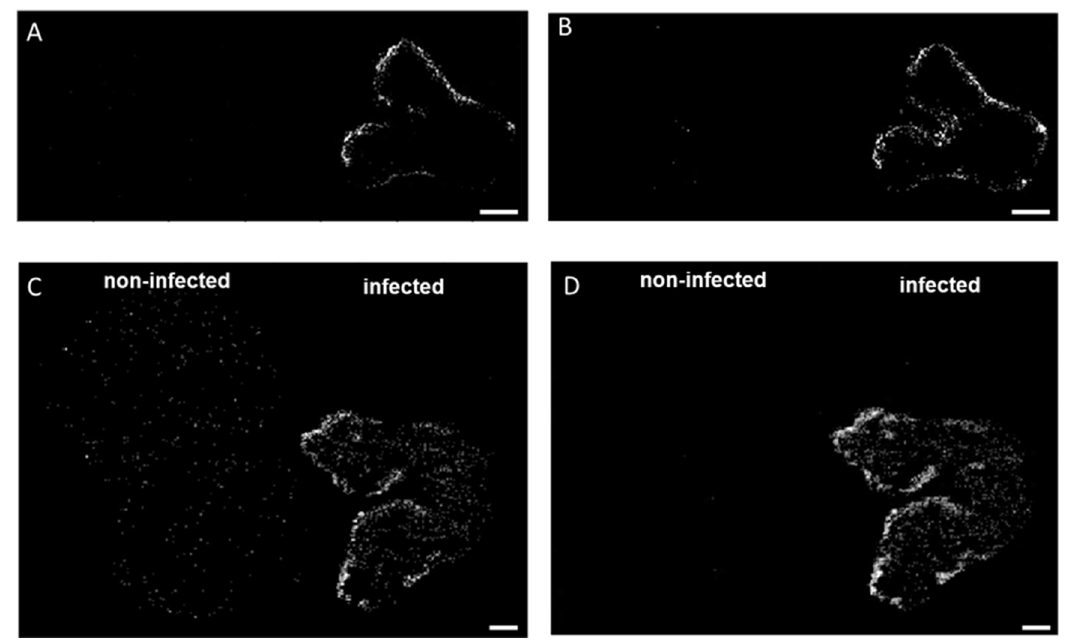
Figure 2. Spatial distribution of diacylglycerols in durum ( A , B ) and common wheat ( C , D ) cross-sections. ( A , C ) DG (33:4) [M + K] + m/z 613.4228 and ( B , D ) DG (33:3) [M + K] + m/z 615.4385 were found exclusively in the infected seeds. MS images were generated with ( A , B ) 336 × 138 pixels; 20 µm pixel size; m/z bin width: ±5 ppm; scale bars: 500 µm; ( C , D ) 300 × 220 pixels; 15 µm pixel size; m/ z bin width: ±5 ppm; scale bars: 200 µm.